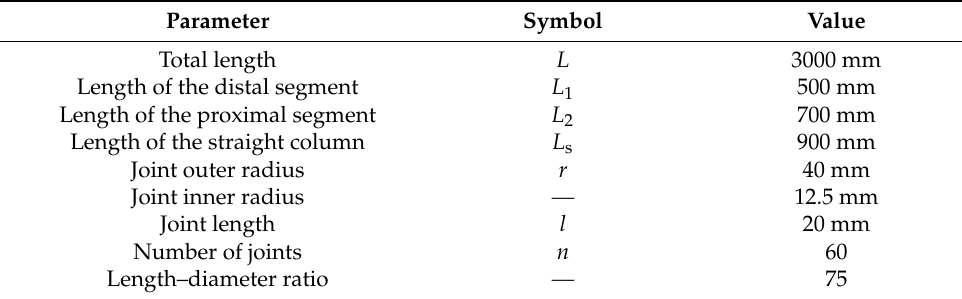
Figure 2. Design of the dual-segment continuum robot: ( a ) whole configuration; ( b . i ) the way the joints are combined; ( b . ii ) the basic configuration of the rolling joint; ( b . iii ) the reachable bending angles of the rolling joints (half stroke); ( c ) the structure and composition of the end-effector. Table 1. The parameters of the continuum robot.